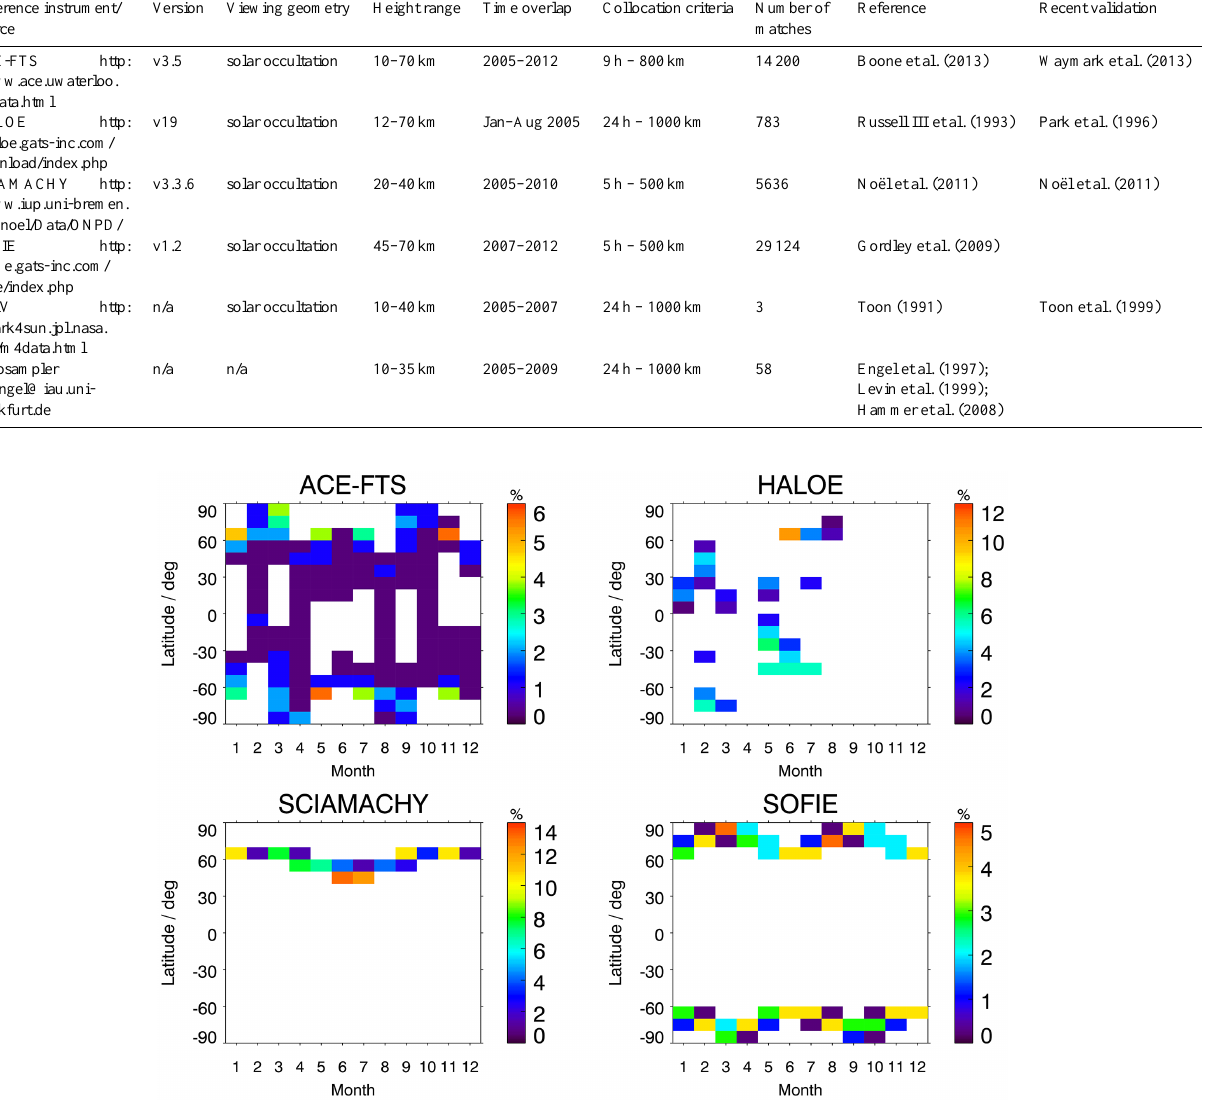
Figure 3. Monthly latitudinal distributions of collocated measurements of MIPAS with reference instruments, in